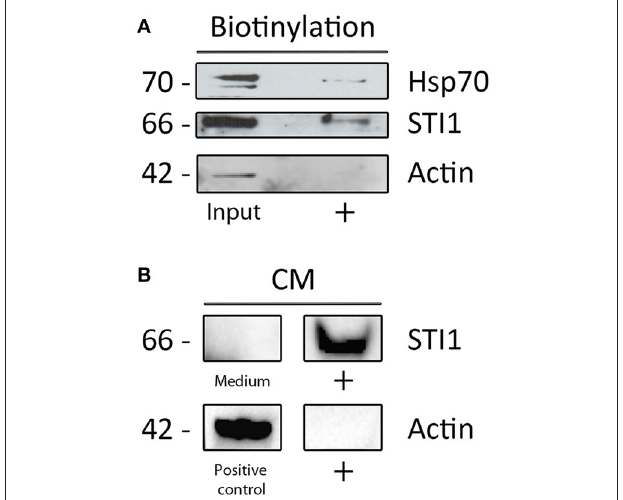
FIGURE 6 | Proteins from the heterocomplex are not only present in cell membranes, but also in conditioned medium. (A) Both HOP/STI1 and Hsp70 are present in biotinylated cell membrane extracts from SVZ. As control, α -actin was not detected in the same fraction analyzed. (B) The co-chaperone HOP/STI1 is also present in conditioned medium (CM) collected from SVZ primary cultures, α -actin was not detected in the CM